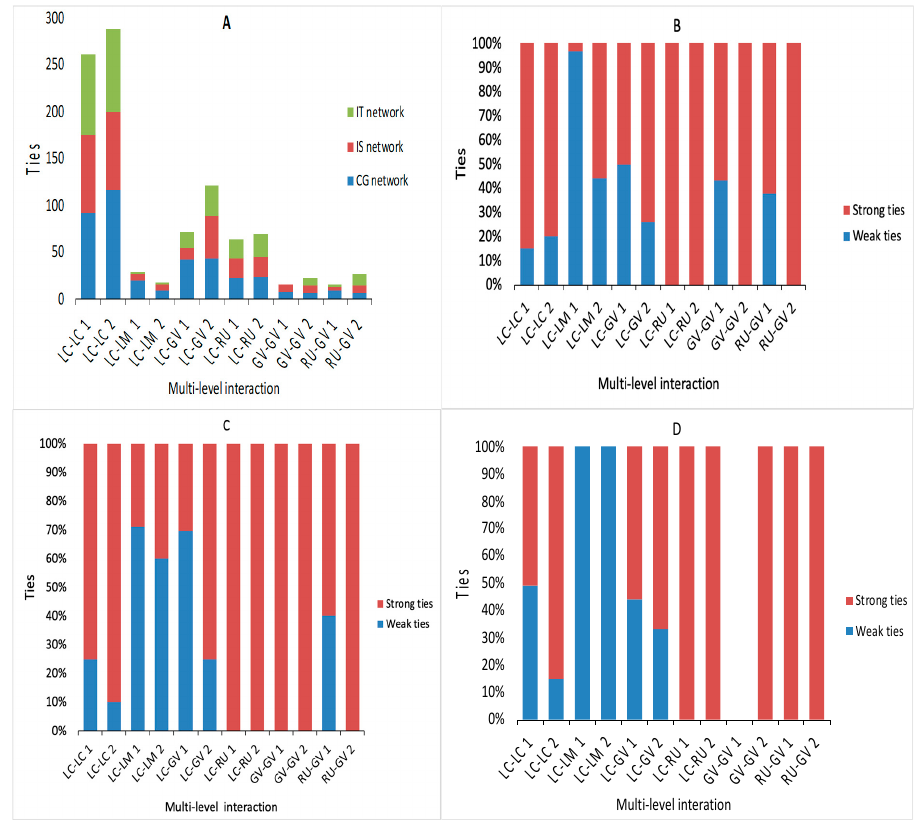
Figure 6. Distribution of multi-actor and multi-level ties across three networks. ( A ) depicts the Figure 6 : Distribution of multi-actor and multi-level ties across three networks. Figure 6A depicts the distribution of ties across three governance networks i.e. IT (inter-organisational trust network), IS distribution of ties across three governance networks, i.e., IT (inter-organisational trust network), (information sharing network) and CG (Common goals network) between Phase 1 and Phase 2. Figures IS (information-sharing network), and CG (Common goals network) between Phase 1 and Phase 2. 6B, C and D depict the distribution of strong vs. weak ties across three governance networks (common ( B ), ( C ) and ( D ) depict the distribution of strong versus weak ties across three governance networks goals, information sharing and inter-organisational trust networks). LC (Local hubs), LM (Local (common goals, information sharing, and inter-organisational trust networks). LC (Local hubs), municipality), GV (Government), RU (Rhodes University). LM (Local municipality), GV (Government), RU (Rhodes